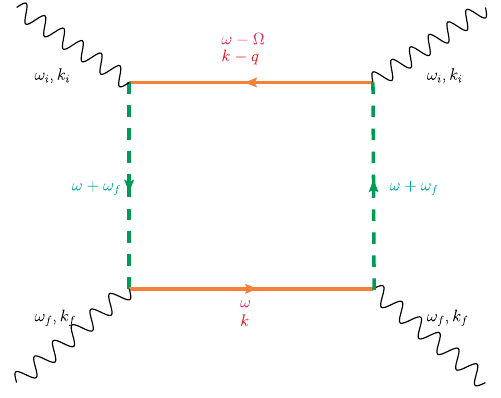
suppressed.FIG. 1. Electron-hole contribution to RIXS (bare diagram). The dotted lines denote the Cu 2 p hole, and solid lines denote the 3 d conduction electrons. Notation for the vertices has been